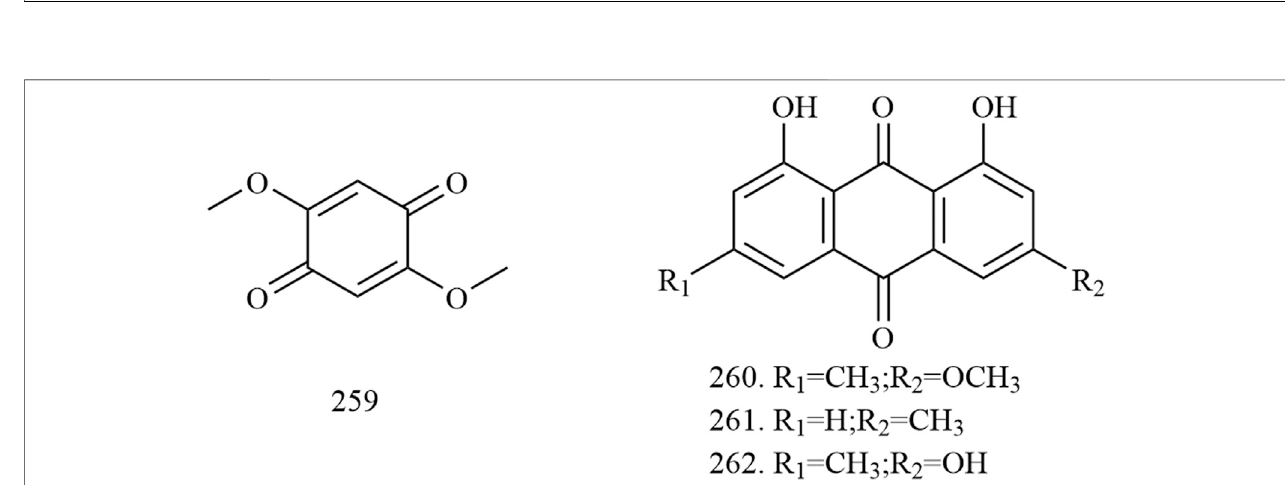
FIGURE 9 | Structures of quinone compounds in X. sorbifolium